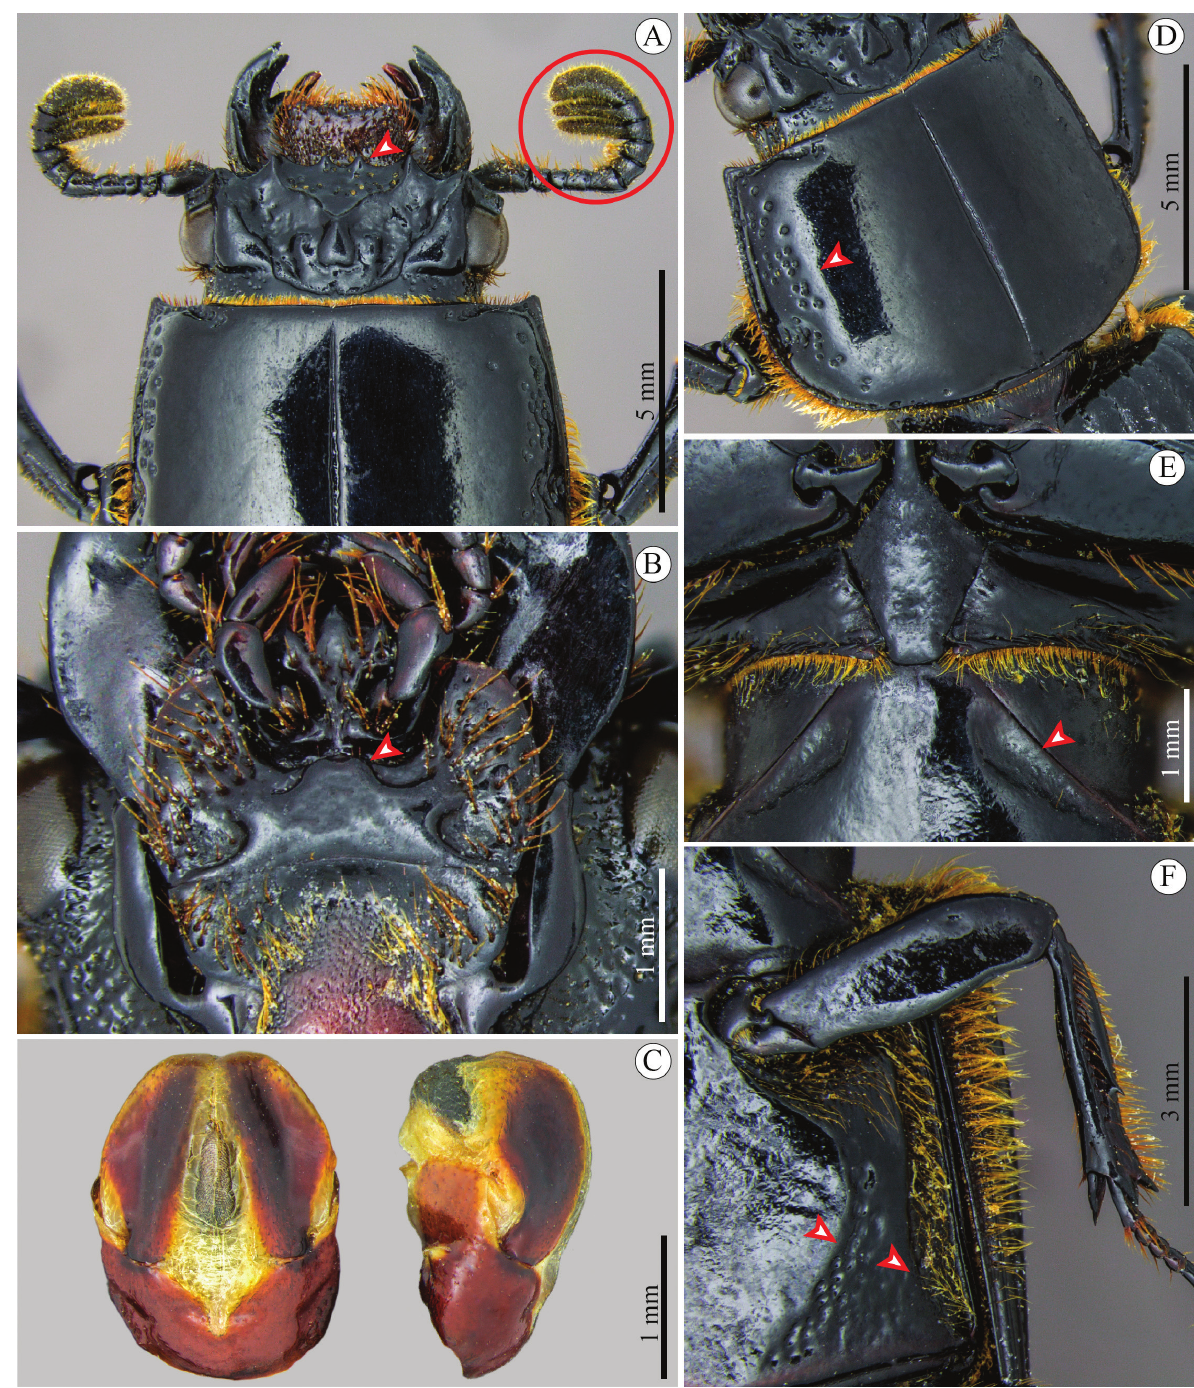
Figure 30. Finished figure containing all edited and cleaned images, evidence elements, scale bars and